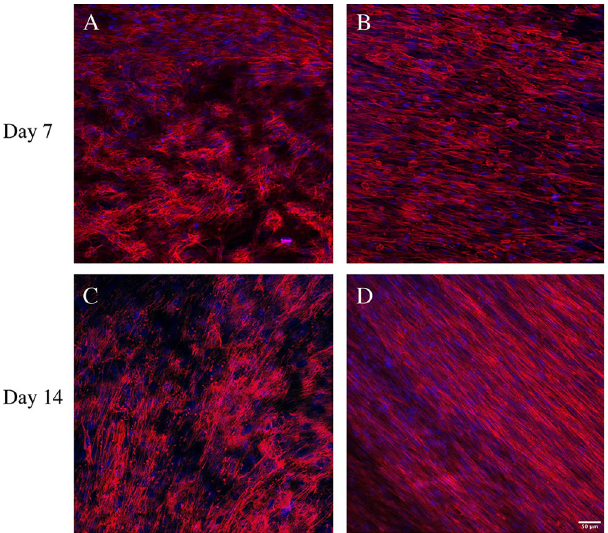
Figure 5. Confocal images of actin filaments in HDF 3D mono-cultures incubated in the absence or presence of TGF-β1. HDF 3D co-cultures were incubated in the absence ( A and C ) or presence of 5 ng/ml TGF-β1 ( B and D ) for 7 and 14 days in 3D scaffolds, respectively. The cultures were fixed in 3.7% formaldehyde and stained to visualize actin filaments (red) and cell nuclei (blue). The images were taken in the centre of 3D cultures All images are representative of 3 independent experiments. Scale bar is 50